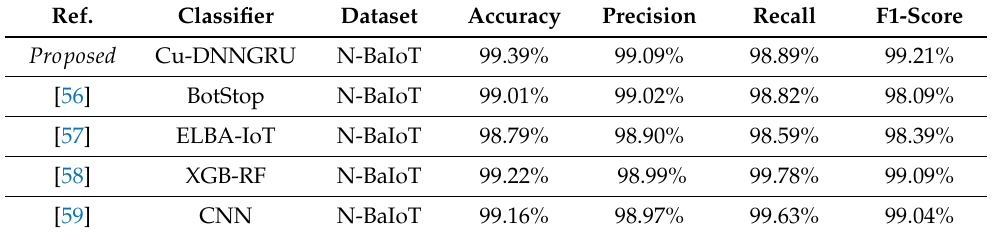
Table 7. Comparison of the proposed model with recent threat detection approaches.